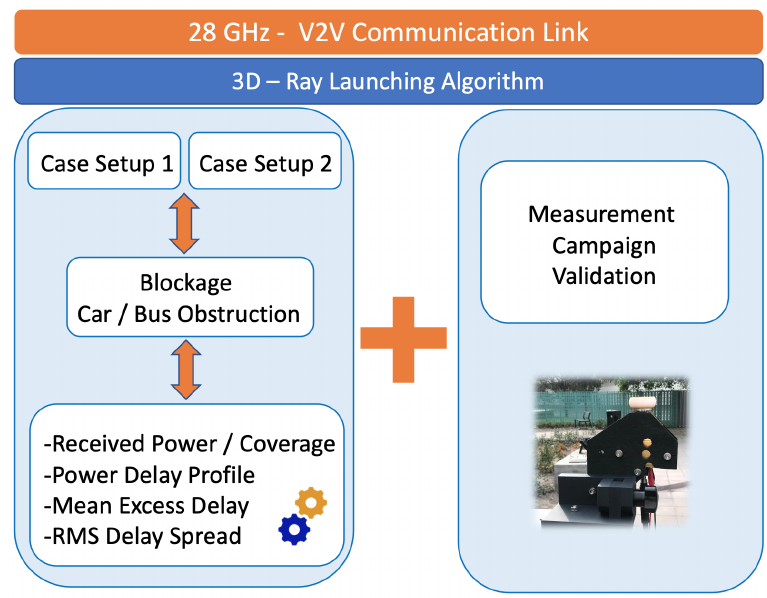
Figure 9. Schematic diagram of the approach presented in this work.